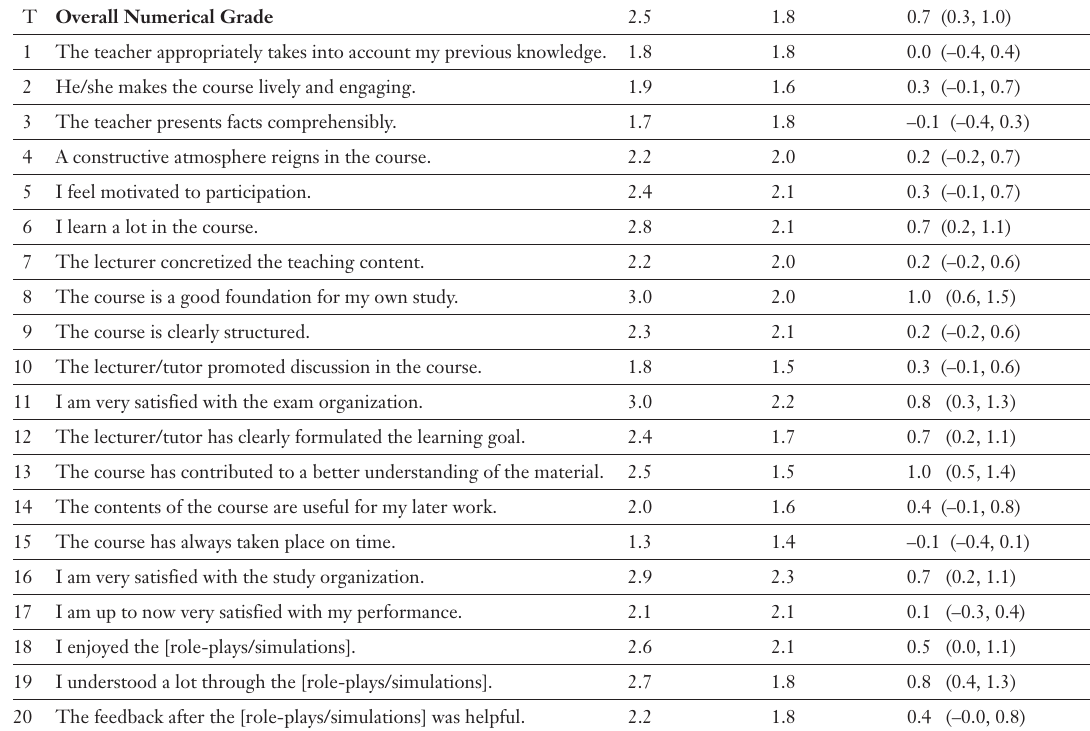
Table 2. Differences, between students from German-language secondary schools and students from foreign-language secondary schools, in the quantitative student evaluation of the Medical Psychol- ogy and Research Methodology courses. The means have been adjusted for age and sex. The last column presents the difference be- tween these means and the 95% confi- dence interval within which the true differ- ence could lie.